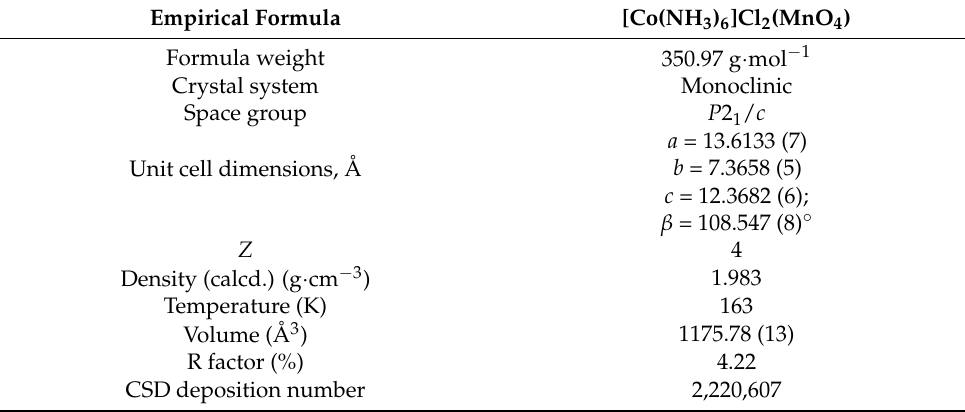
Table 2. Crystal data of compound 1